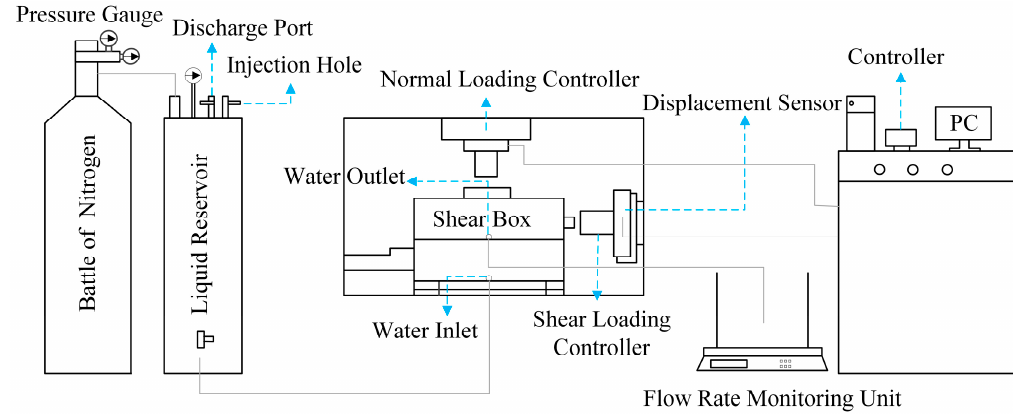
Figure 1. Structure diagram of shear-flow coupled test system.